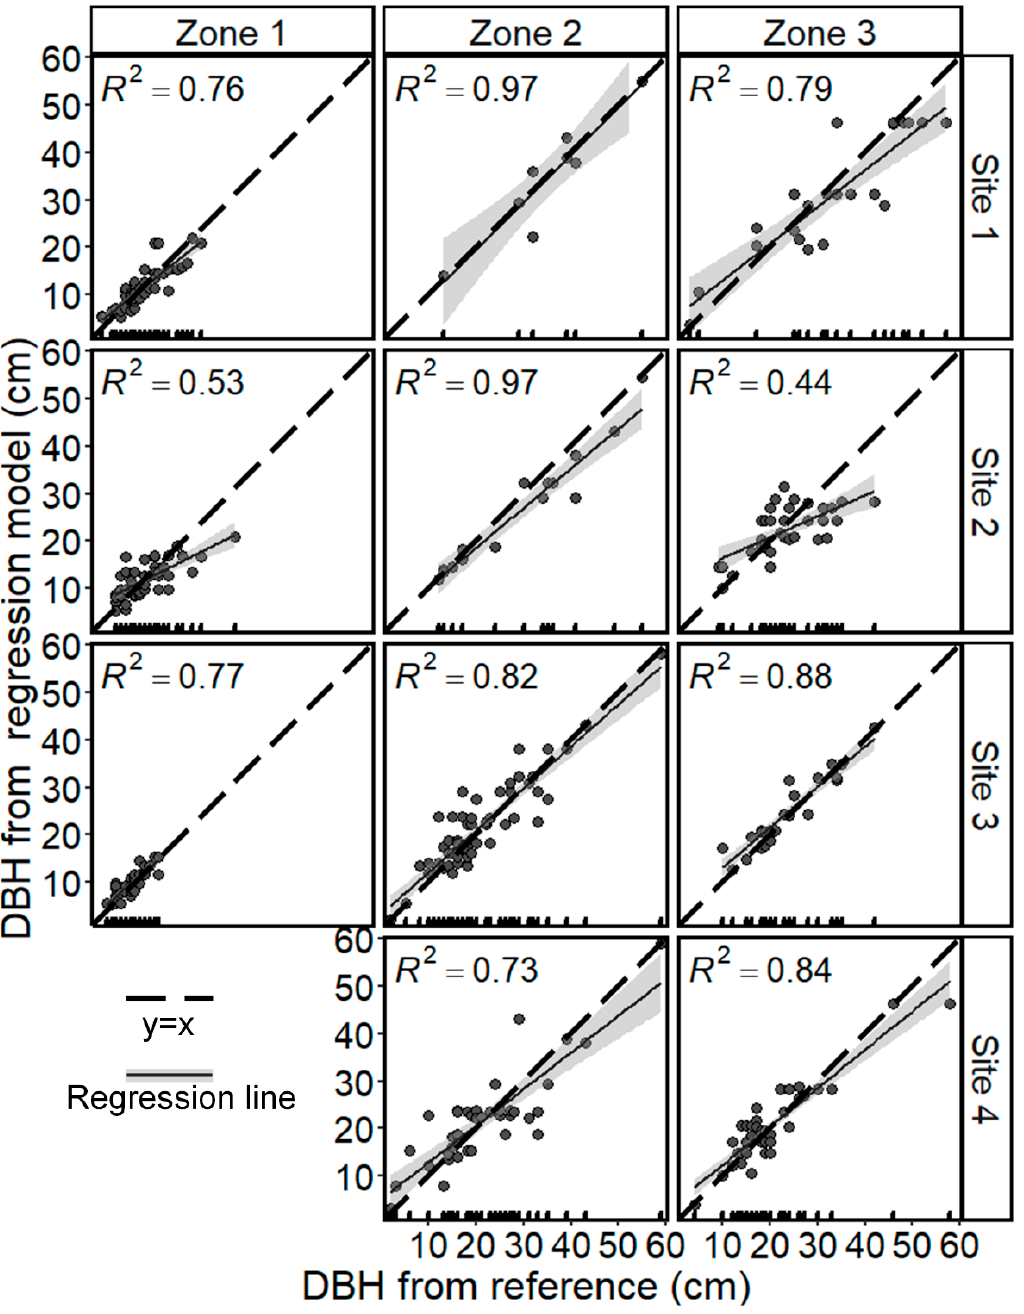
Figure A3. Site-specific comparison of DBH estimated from multivariate linear regression model with independent variables of height (H) and canopy area (A) in trees with high stand form.